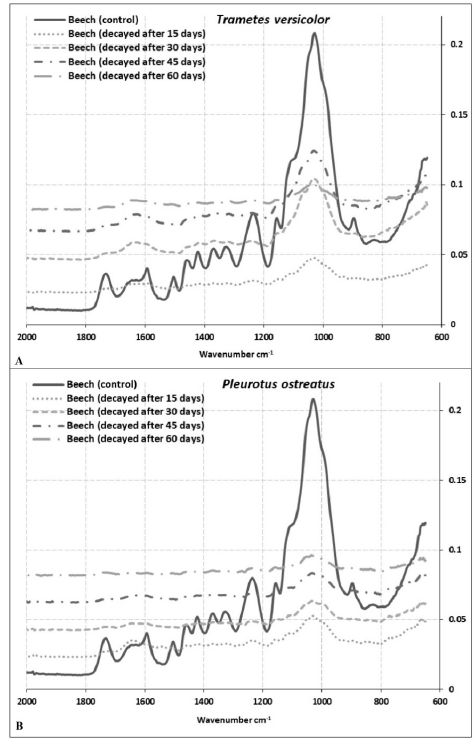
Figure 4. Total FT-IR spectra of beech wood samples exposed to T. versicolor ( A ) and P. ostreatus ( B ) for 60 days.